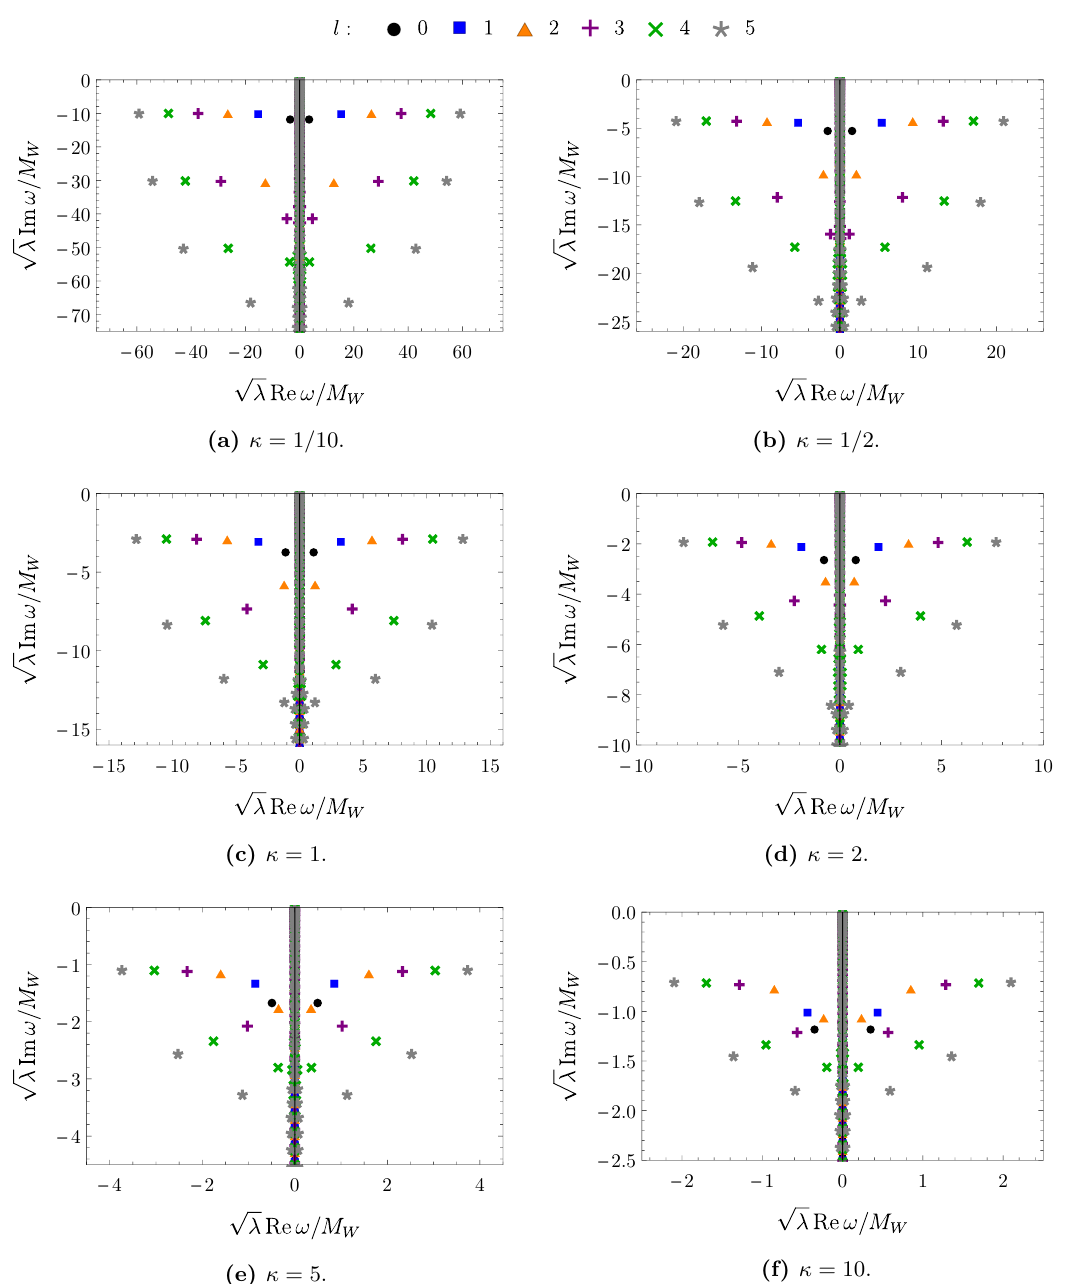
√ Figure 3. QNM frequencies, in units of M W / λ , for l = 0 to l = 5 and various values of κ . All results were obtained using Leaver’s method with 300 × 300 matrices. For all l , we find many modes on the negative imaginary axis, consistent with a branch cut. We also find pairs of isolated modes with equal and opposite real parts, the number of which increases as we increase l